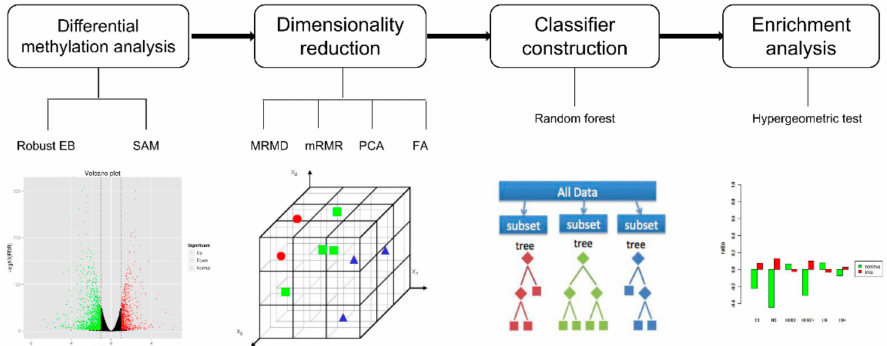
Figure 1. Schematic diagram of the presented stepwise analysis. Step 1, di ff erential methylation analysis: Two methods were carried out to select the di ff erential methylation sites. Step 2, dimensionality reduction: using four methods to reduce the dimension. Step 3, four kinds of dimensionality reduction results were used to construct the classifier respectively. Step 4, enrichment analysis: Hypergeometric test evaluated and compared the performances of the